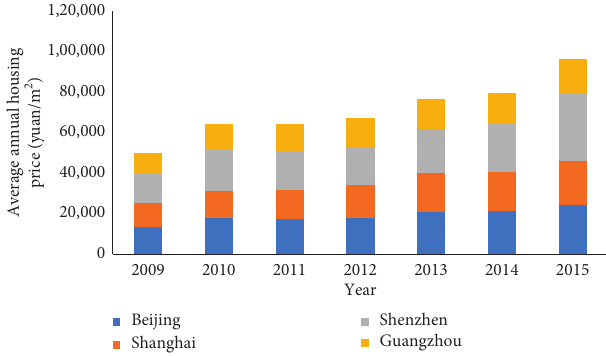
Figure 2: Increasing of housing price in